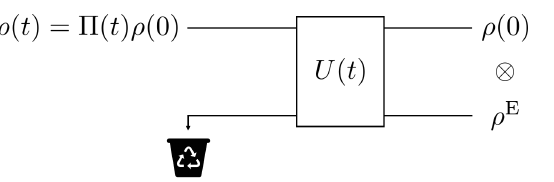
Figure 1: Open system evolution as a quantum circuit: The evolution Π ( t ) is obtained by tracing out the environment after joint unitary evolution. The trashcan indicates the inaccessible or discarded information about the state of the